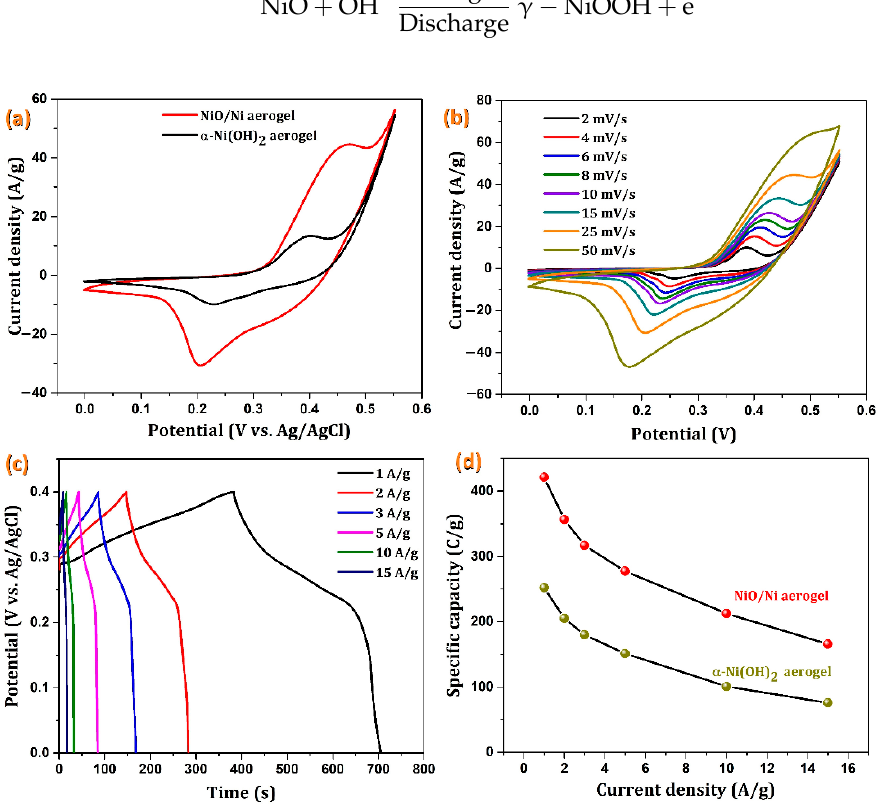
Figure 5. ( a ) CVs of the α -Ni(OH) 2 - and NiO/Ni-modified nickel foam electrodes, ( b ) dependence of the scan rate of the NiO/Ni electrode, ( c ) GCD of the NiO/Ni/NF electrode, and ( d ) plot of the specific capacity vs. the current densities of the NiO/Ni/NF electrodes.